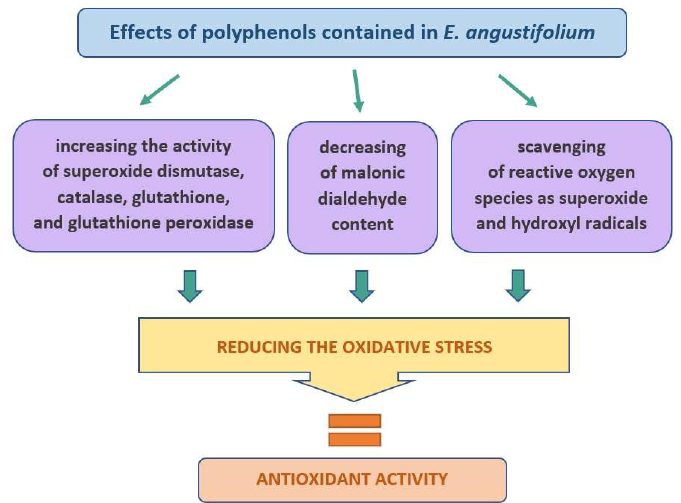
Figure 4. A diagram showing schematically the mechanism of antioxidant activity of the ingredients contained in E. angustifolium. contained in E. angustifolium